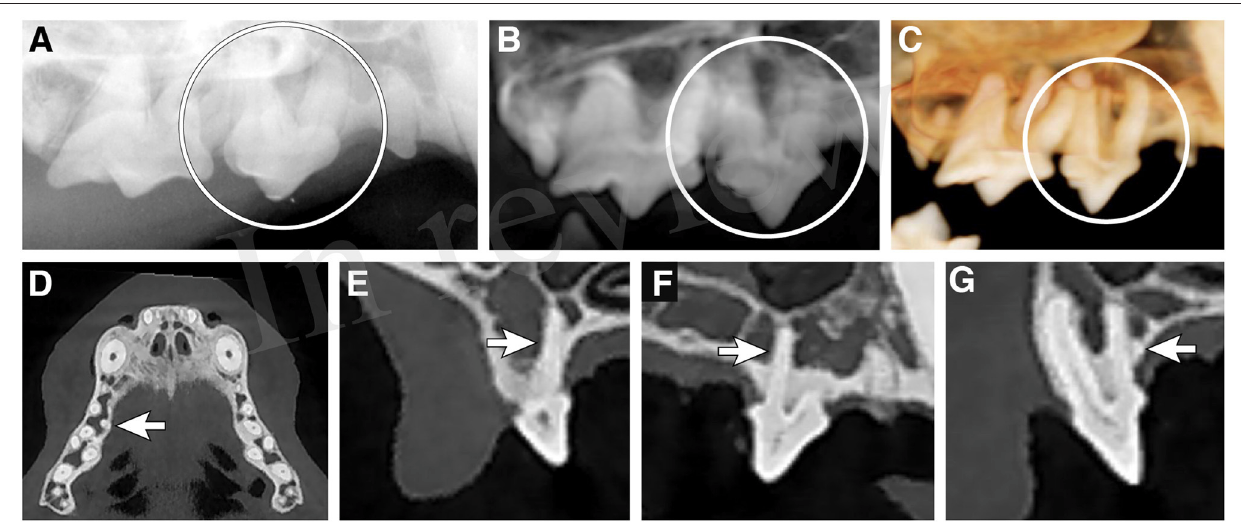
FIGURE 3 | Supernumerary root. Evaluation of a right maxillary fourth premolar tooth supernumerary root. (A) Dental radiograph of right maxillary second premolar tooth through first molar tooth obtained with the extraoral, near parallel radiographic technique, (B) reconstructed panoramic view with the axis of the skull adjusted for orientation of the right maxillary canine tooth through first molar tooth, (C) tridimensional (3-D) rendering in tooth mode of the right maxillary premolar and molar teeth, (D) axial section multiplanar reconstruction showing apex of the supernumerary root of the right maxillary third premolar tooth, (E) coronal section multiplanar reconstruction showing the supernumerary root of the right maxillary third premolar tooth, (F) sagittal section multiplanar reconstruction showing the supernumerary root of the right maxillary third premolar tooth, (G) custom cross-section multiplanar reconstruction showing the supernumerary root of the right maxillary third premolar